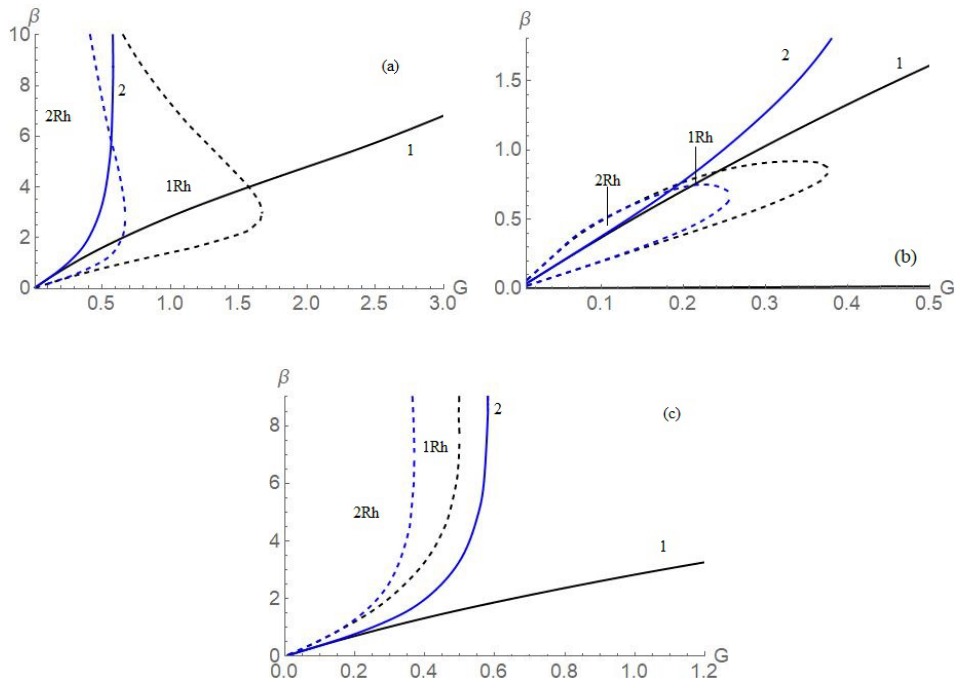
Figure 4. Pattern selection domains for the rhombic lattice. The solid lines are for κ 1 = 0, the dashed lines are for κ 1 + ˜ κ 2 ( θ ) = 0. Here, the black color set (#1 ) is for N = 0, the blue-colored set (#2 ) is for N = 10 − 6 . The stability domains are marked: “1Rh” is for N = 0, “2Rh” for N = 10 − 6 . Panel ( a ): θ = 0.45 π , panel ( b ): θ = 0.4 π , and panel ( c ): θ = 0.25 π . Each panel includes two cases of different N ; the black color lines are for N = 0 and the blue ones are for N = 10 − 6 . It is shown that surfactant diminishes the regions of stable rhombi. The calculations show that the most dangerous perturbations are directed by θ = π